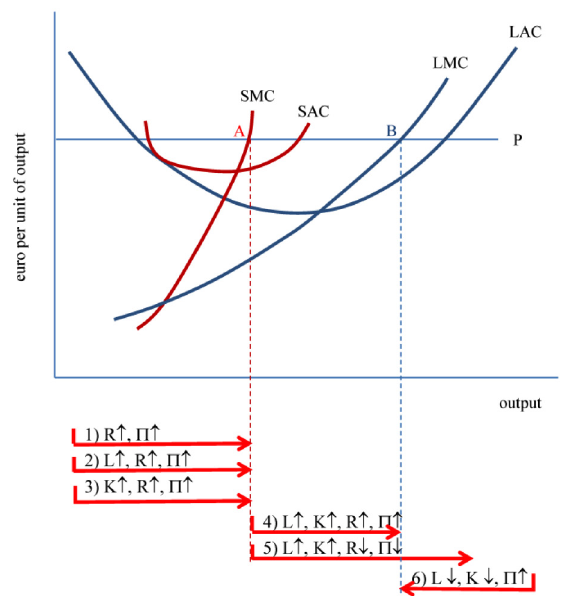
Figure 1. Types of growth according to the firm’s adjustment to short- and long-run